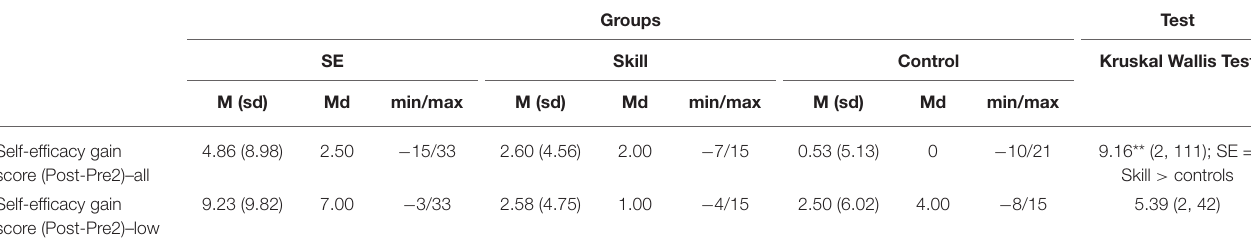
TABLE 4 | Comparison of gain scores in self-efficacy during intervention (RQ1). Groups Test SE Skill